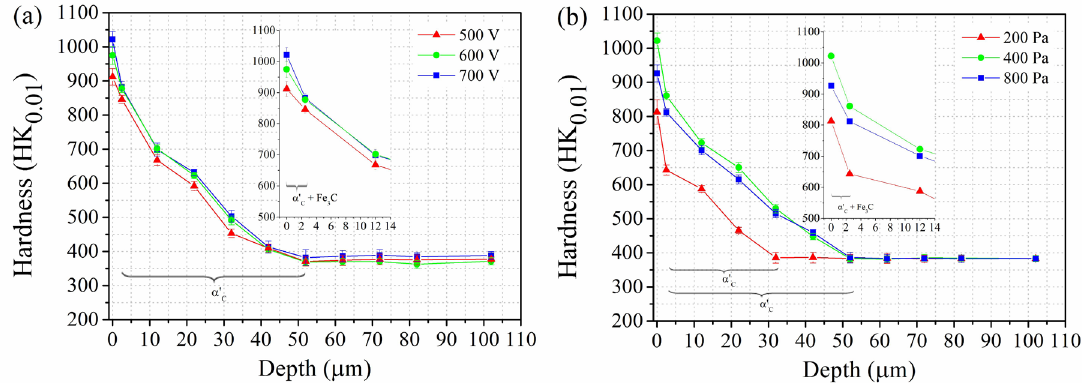
Figure 3. Knoop hardness profiles measured on the carburized samples obtained for: a) applied pulse voltage; and b) pressure treatment series. Treatments carried out at 450 °C, for 8 h, using 99.5% (80% H